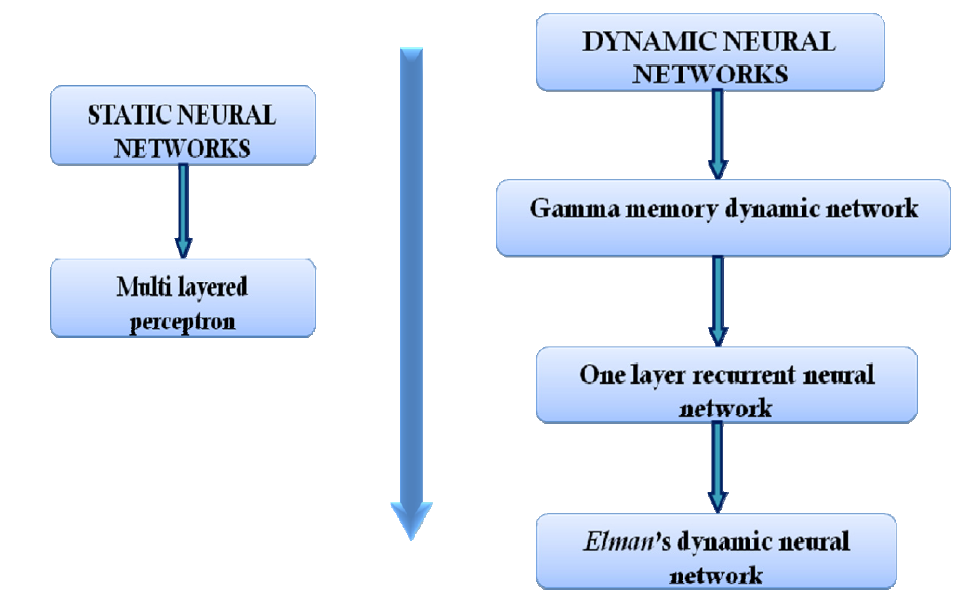
Figure 8. Flow diagram for the network architecture selection [30].